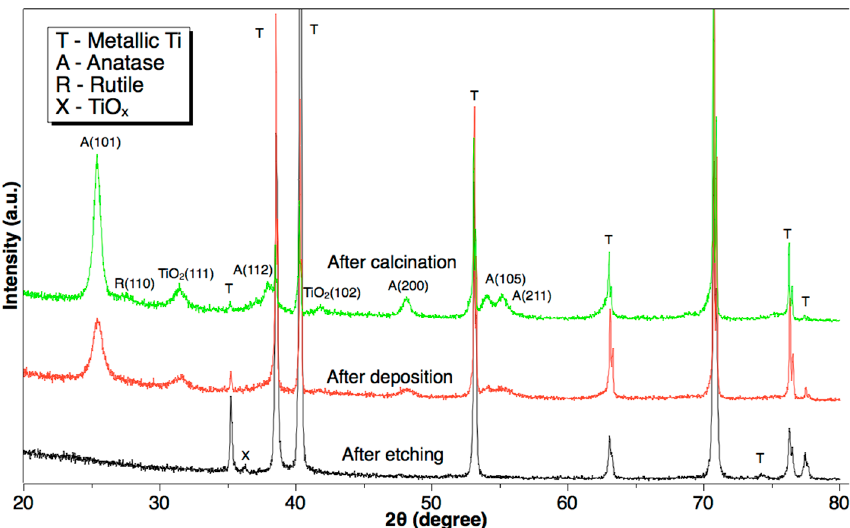
Figure 3. X-ray diffraction patterns of TiO 2 obtained using metallic Ti after each step. Undefined TiO 2 belongs to the Joint Committee on Powder Diffraction Standards (JCPDS) card 21-1236; X is TiO x with JCPDS card 43-1295. The content of the insert text box are abbreviations for each substance, which are T for metallic Ti, A for Anatase TiO 2 , R for Rutile TiO 2 , X for TiO X , respectively. a.u.: arbitrary units.